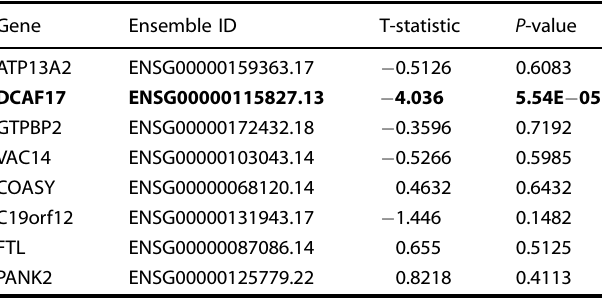
Table 2. Results of transcriptomic analysis using blood PPMI